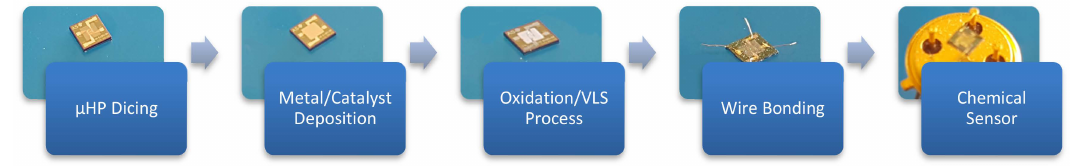
Figure 2. Flow-chart of the integration of metal oxide (MOX) nanowires on ams µ HPs to fabricate chemical